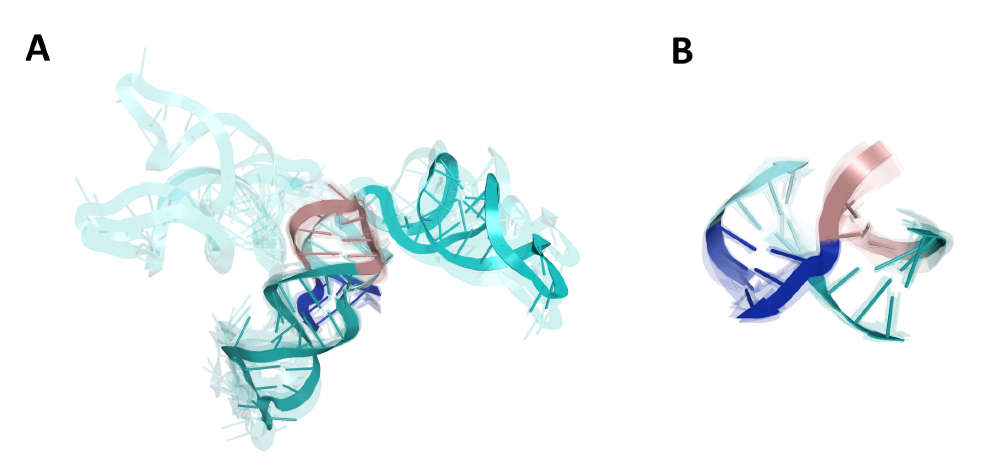
Figure 4. Four-way junction (4WJ) of SL5abc in the 5 (cid:48) -UTR region. ( A ) The ensemble of 3D RNA structures that belong to the cH family [52] with two pairs of coaxial stacks SL5-stem/SL5a and SL5b/SL5c that constitute the largest cluster (nine members). ( B ) 4WJ rotated 90-degrees around the y-axis. Domains: SL5a (cyan), SL5b (deep teal), SL5c (dirtyviolet), and SL5 stem (blue).